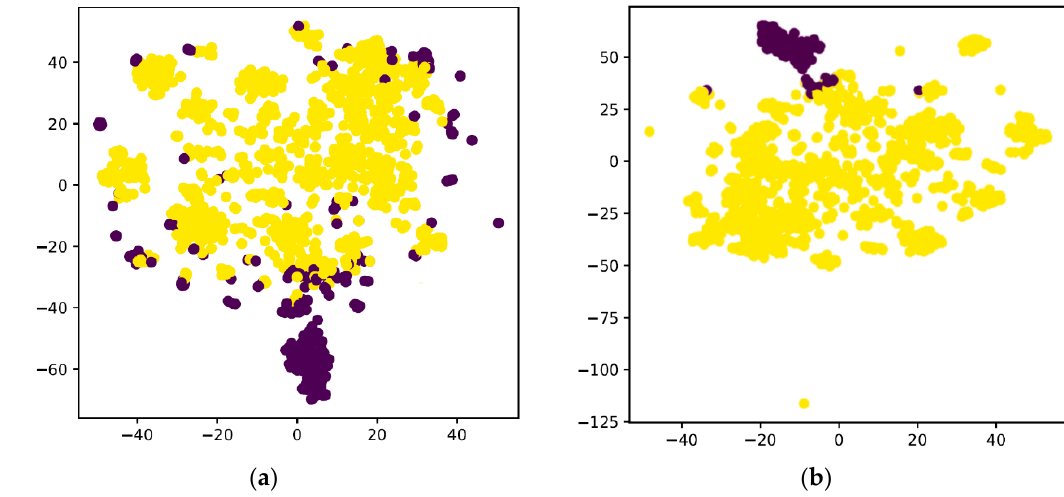
Figure 4. ( a ) the t-SNE result by K-means; ( b ) the result by isolation forest.